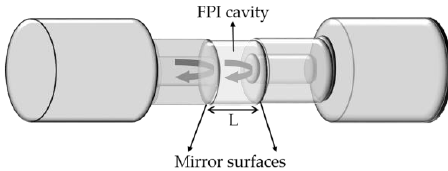
Figure 11. Schematic representation of a FPI.